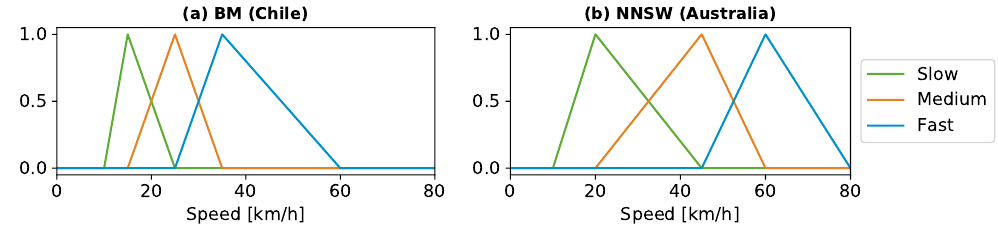
Figure 6. Exemplary MF speed for ( a ) the BM (Chile) regions and ( b ) NNSW (Australia) for class = Tertiary and Surface = Unpaved . See all MF speeds in [19].